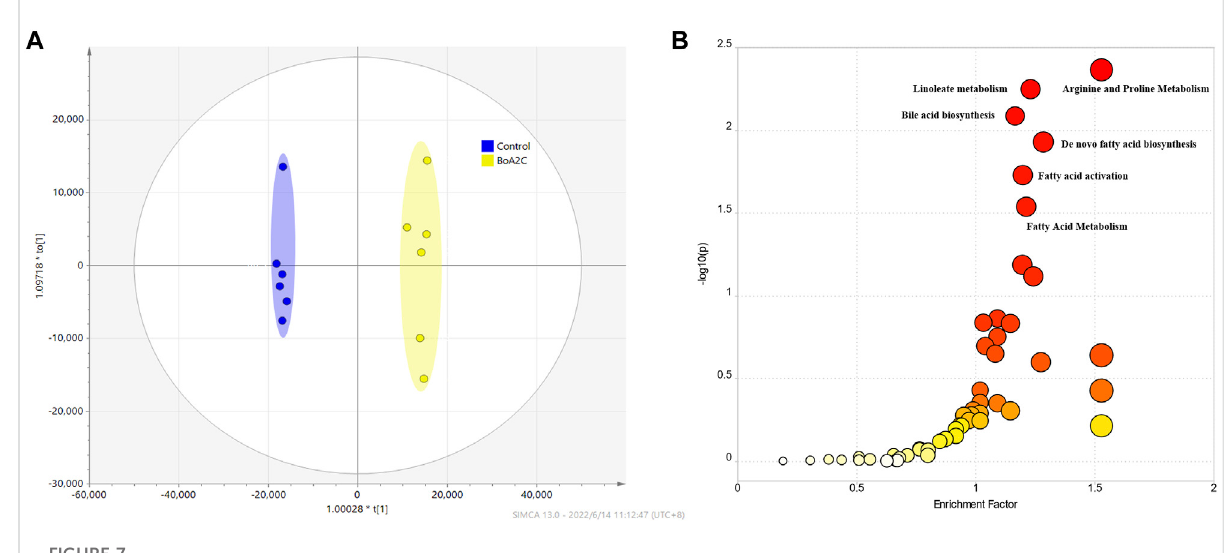
FIGURE 7 Metabolomicsstudy for BoA2C inMCF-7cells. (A) OPLS-DAscoreplotsof BoA2C andcontrolgroup. (B) KEGGpathway enrichmentanalysis of differential metabolites between BoA2C and control